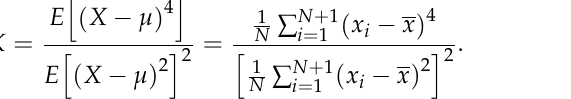
Step 1: Extract a dataset of n values, represented as x = { x 1 , x 2 , · · · , x n } , around the rough arrival time determined by Hilbert-Huang